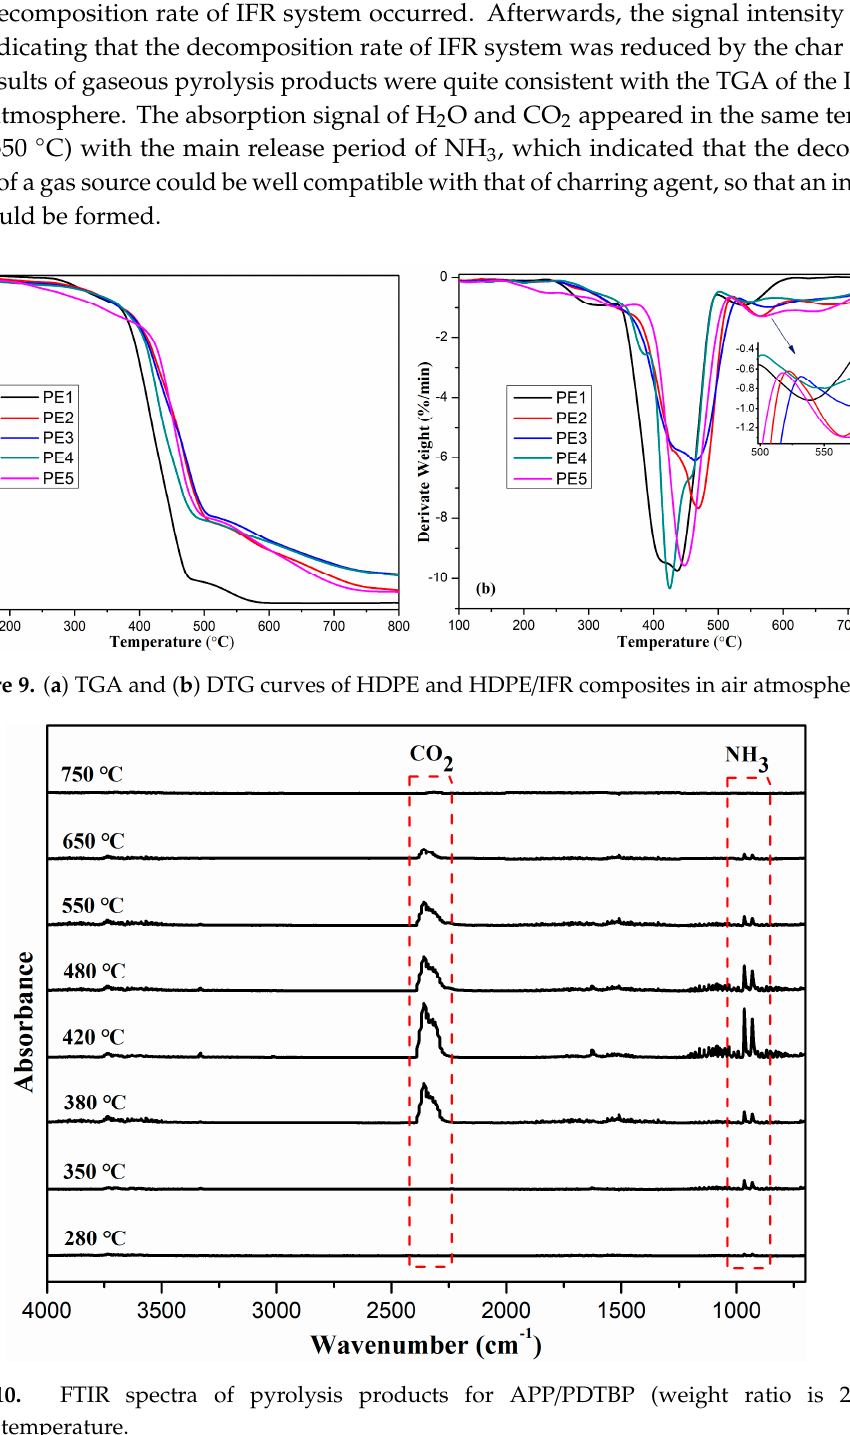
Figure 10. FTIR spectra of pyrolysis products for APP/PDTBP (weight ratio is 2:1) at different temperature.